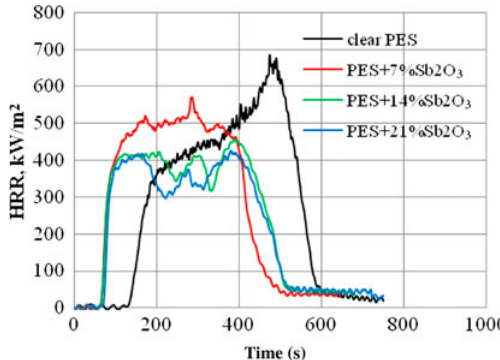
Fig. 3. Heat release rate for polyester material unmodified and modified with Sb 2 O 3 at the heat flux density of 30 kW/m 2 on piloted ignition